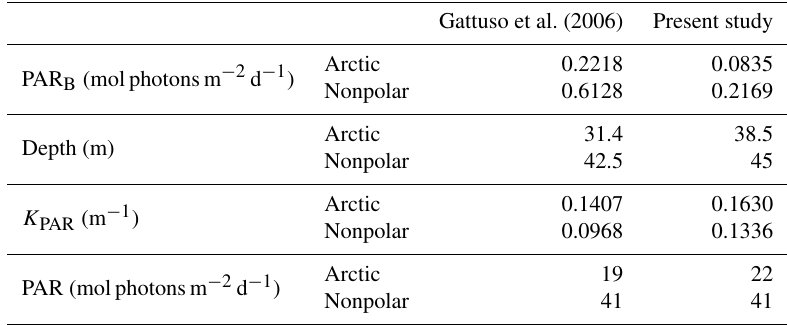
Table 4. Median values of key variables used by Gattuso et al. (2006) and the present